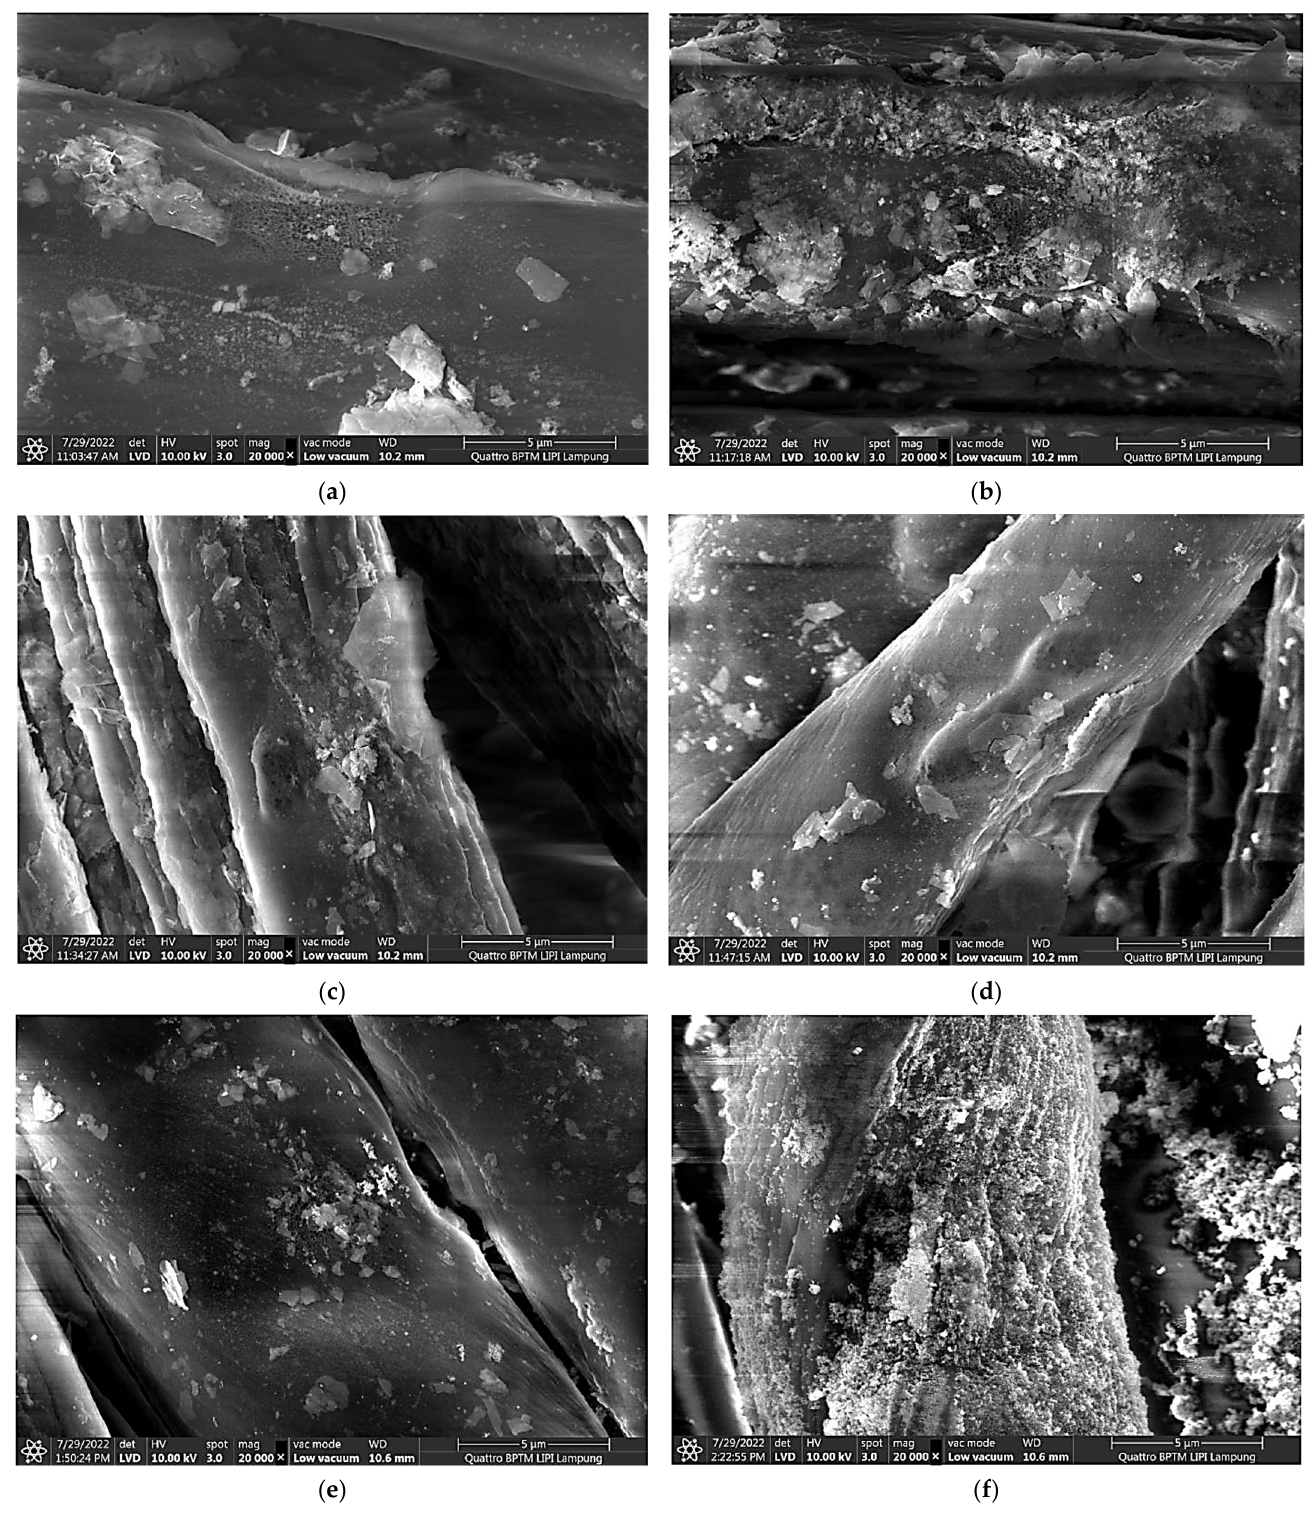
Figure 4. Morphology (FESEM image) of ND-colored Batik fabric surface after in situ immobilization of ZnO NPs at various pH: ( a ) pH 6, ( b ) pH 7, ( c ) pH 8, ( d ) pH 9, ( e ) pH 10, ( f ) pH 11. The interaction between the ZnO NPs and the cellulosic chains of cotton fabric (Batik fabric) was analyzed using FT-IR. Figure 5 demonstrates the FT-IR spectra of untreated (Figure 5a), ZnO NPs-treated ND-colored Batik fabric (Figure 5b), and ZnO NPs powder (Figure 5c). The bands of untreated fabric appear at 3410 cm − 1 (O-H stretching), 2900 cm − 1